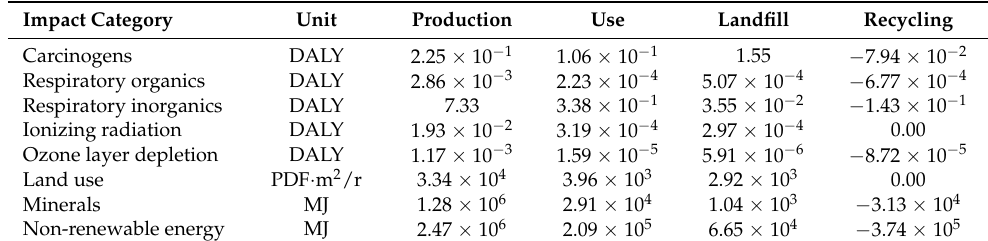
Table 2. The results characterizing the environmental consequences occurring at individual stages of the Vestas V90 wind farm life cycle, taking into account the impact categories [own research].